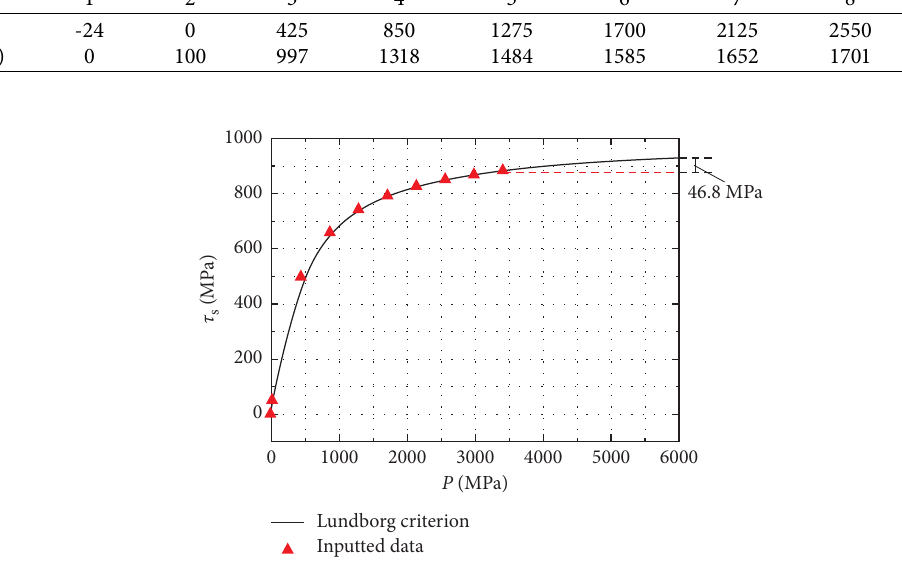
Figure 6: Comparison of the Lundborg criterion and inputted data.